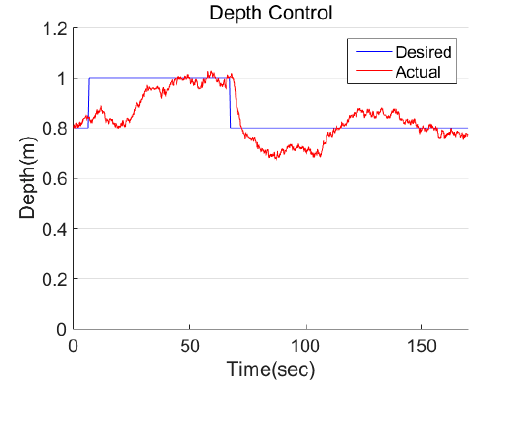
Figure 9. TUP experiment result in water tank (1 knot).